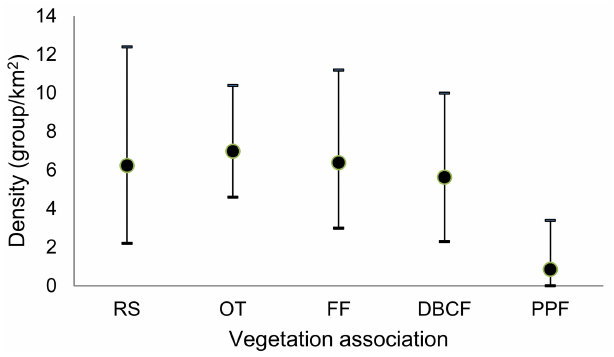
Fig. 3 . Habitat-specific Buff-throated Partridge ( Tetraophasis szechenyii ) density estimates and 95% confidence